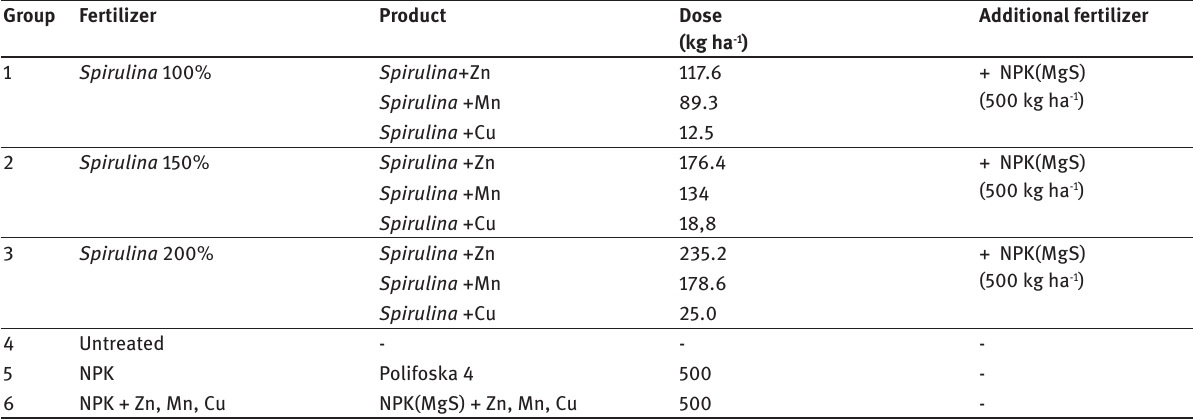
Table 1: Fertilizers doses. Group